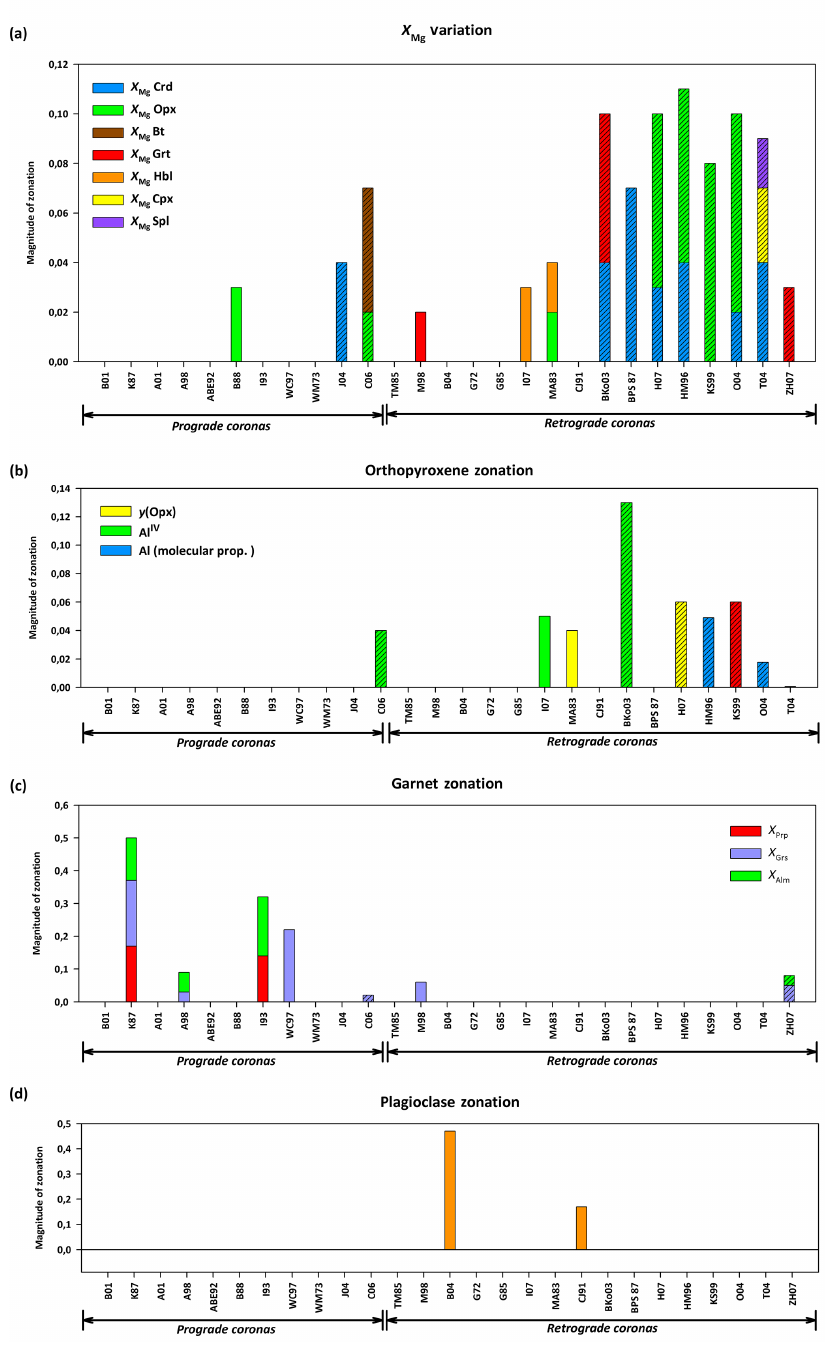
Figure 12. Magnitude of compositional zonation in product corona bands. Hatched fields indicate pelitic bulk rock compositions; unhatched fields are mafic. (a) X Mg variation in product phases. (b) Variation in Al content in orthopyroxene across each corona. (c) Garnet zonation across each corona. (d) Plagioclase zonation across coronas where it is